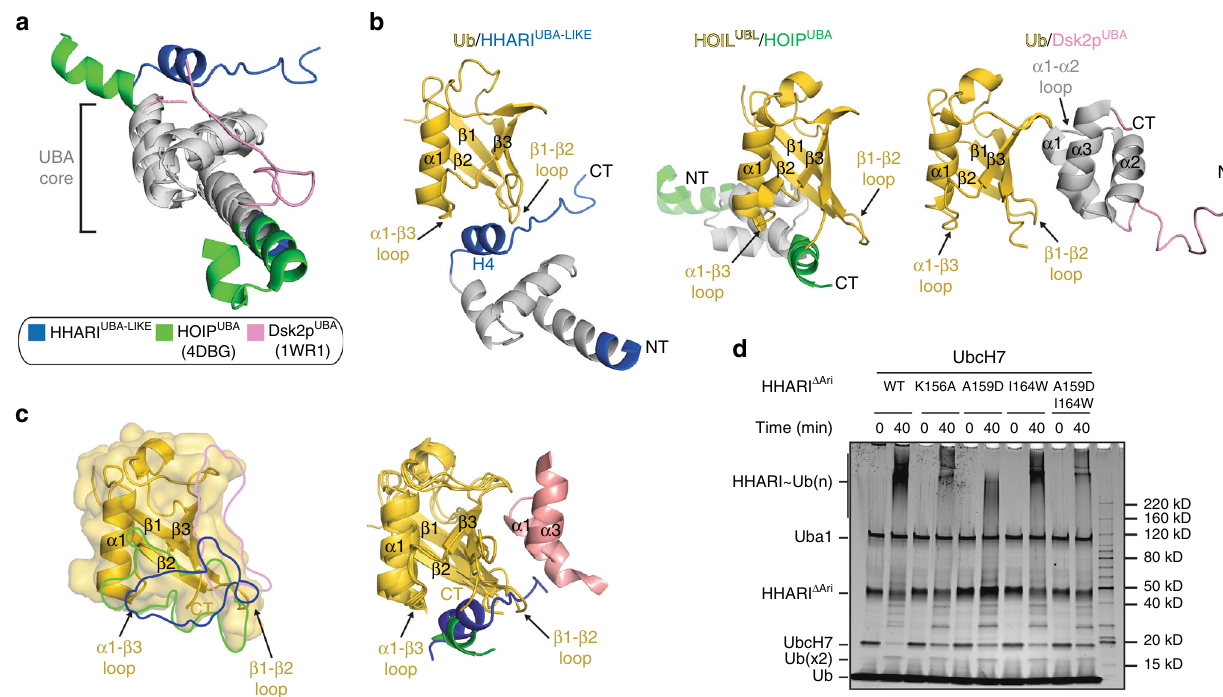
Fig. 6 Analysis of the HHARI UBA-like /Ub interface. a Structural comparison of the UBA domains of HHARI, HOIP (PDB: 4DBG), and Dsk2p (PDB: 1WR1). The conserved three helix core of the UBA domains are colored gray and N- and C-terminal extensions unique to each protein are colored as indicated. b Comparison of the Ub/Ubl binding mode of the UBA domains of HHARI, HOIP, and Dsk2p. Ub/Ubl ( gold ) from the HHARI/UbcH7-Ub, HOIP UBA / HOIL1 UBL (PDB: 4DBG), and Ub/Dsk2p UBA (PDB: 1WR1) structures were superimposed and are shown in the same orientation. c ( left ) The surfaces of Ub/ Ubl that interact with the UBA-like domain of HHARI, HOIL, and Dsk2p are outlined on the surface of the Ubl domain from the HOIP UBA /HOIL UBL structure. ( right) The Ub/Ubl from the HHARI UBA-like /Ub, HOIP UBA /HOIL UBL , and Dsk2p UBA /Ub structures were superimposed and are shown as cartoon representations. The fragments of the UBA and UBA-like domains that contact the Ub/Ubl domains are shown as cartoon representations colored as in the left panel. d Structure-function analysis of the HHARI UBA-like/Ub interface. The indicated HHARI Δ Ari variants were subjected to autoubiquitination assays with UchH7 for the indicated time points, as described in the Methods